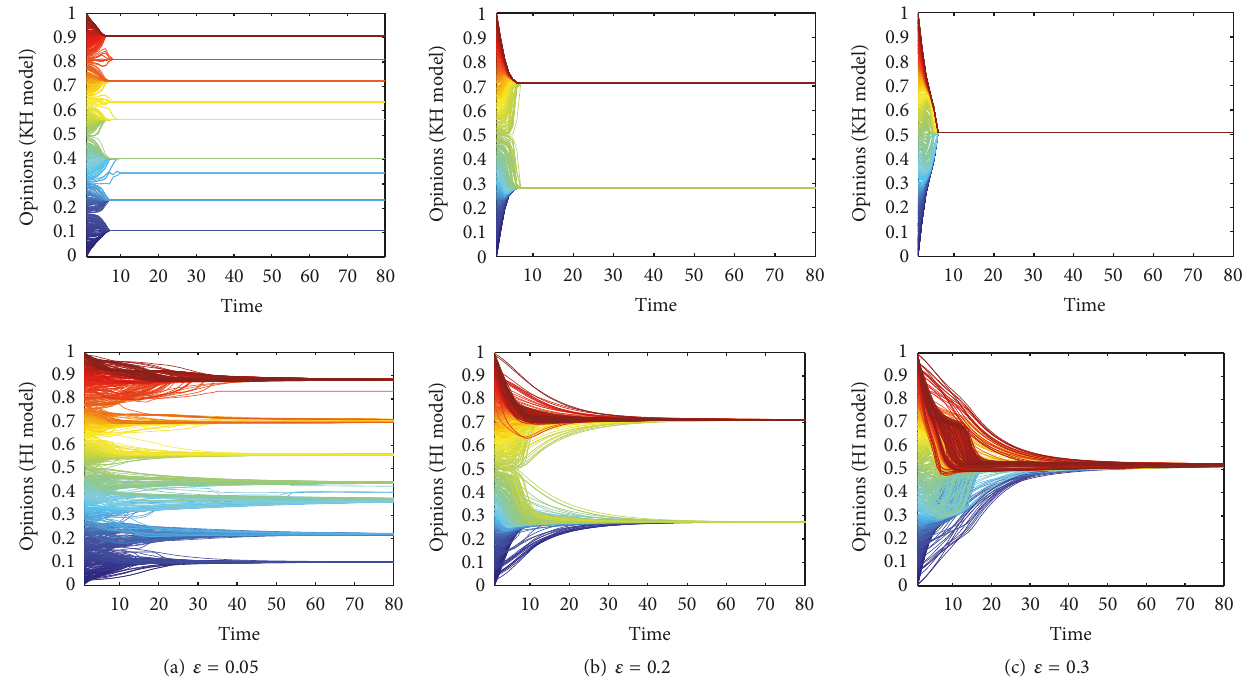
Figure 5: The comparison of public opinion evolution between KH model (the above three figures) and HI model (the three figures below) in full-connected network. 𝜀 : (a) 𝜀 = 0.05 , (b) 𝜀 = 0.2 , and (c) 𝜀 = 0.3 .